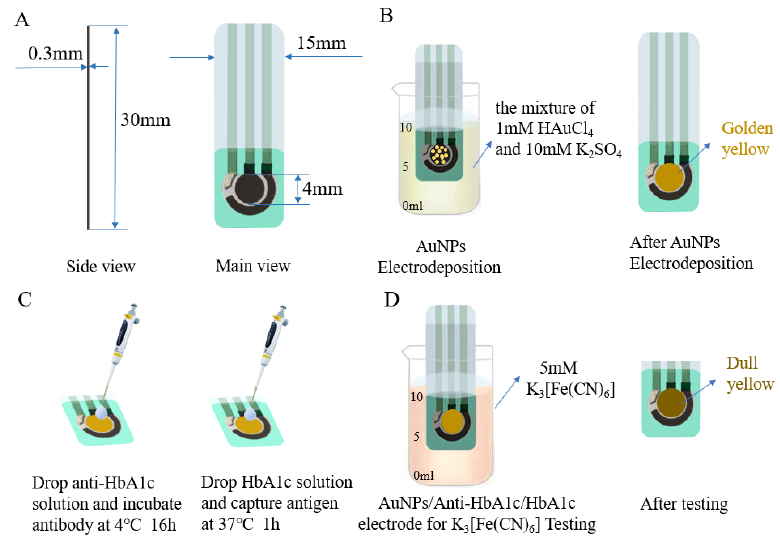
Figure 1. ( A ) Dimensions of the SPE. ( B ) Electrodeposition of SPE in the mixture of 1 mM HAuCl 4 and 10 mM K 2 SO 4 . ( C ) Anti-HbA1c incubation and capture HbA1c. ( D ) AuNPs/anti-HbA1c/HbA1c electrode for K 3 [Fe(CN) 6 ] testing.